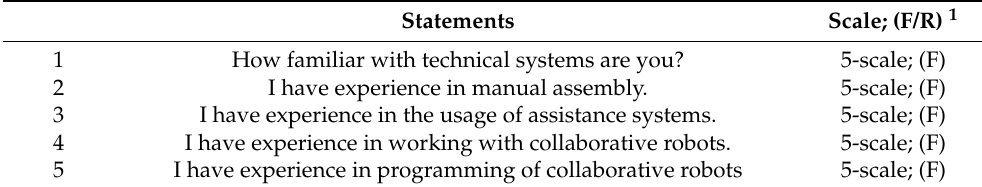
Table A4. Questionnaire for assessing the experience in fields related to the study.